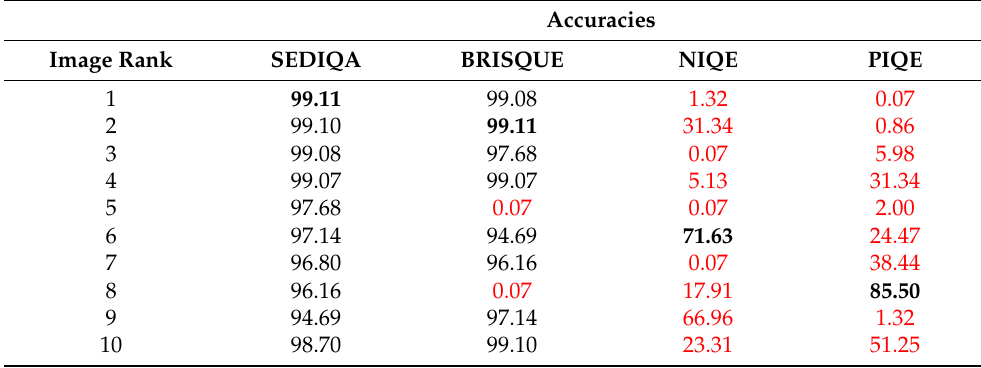
Table 4. Accuracies for best images of document D1 as determined by each NR-IQA. Red denotes unusably low accuracies.